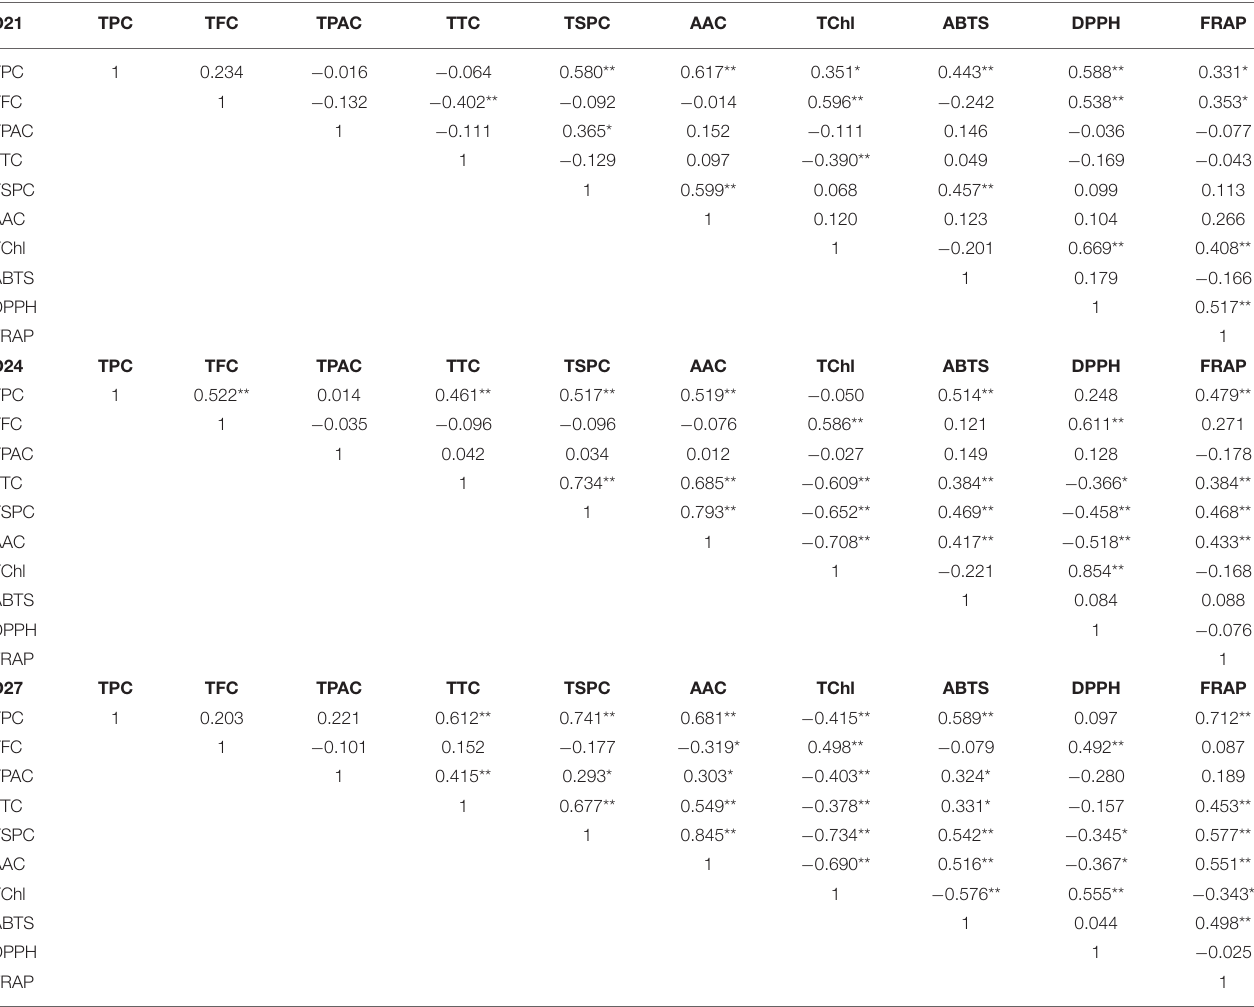
TABLE 3 | Correlation coefficients of total polyphenols, total flavonoids, total proanthocyanins, total triterpenes, total soluble polysaccharides, ascorbic acid, total chlorophyll, abts and dpph scavenging ability, and ferric iron-reducing antioxidant power of wheatgrass on the 21st ∼ 27th harvest day a,b